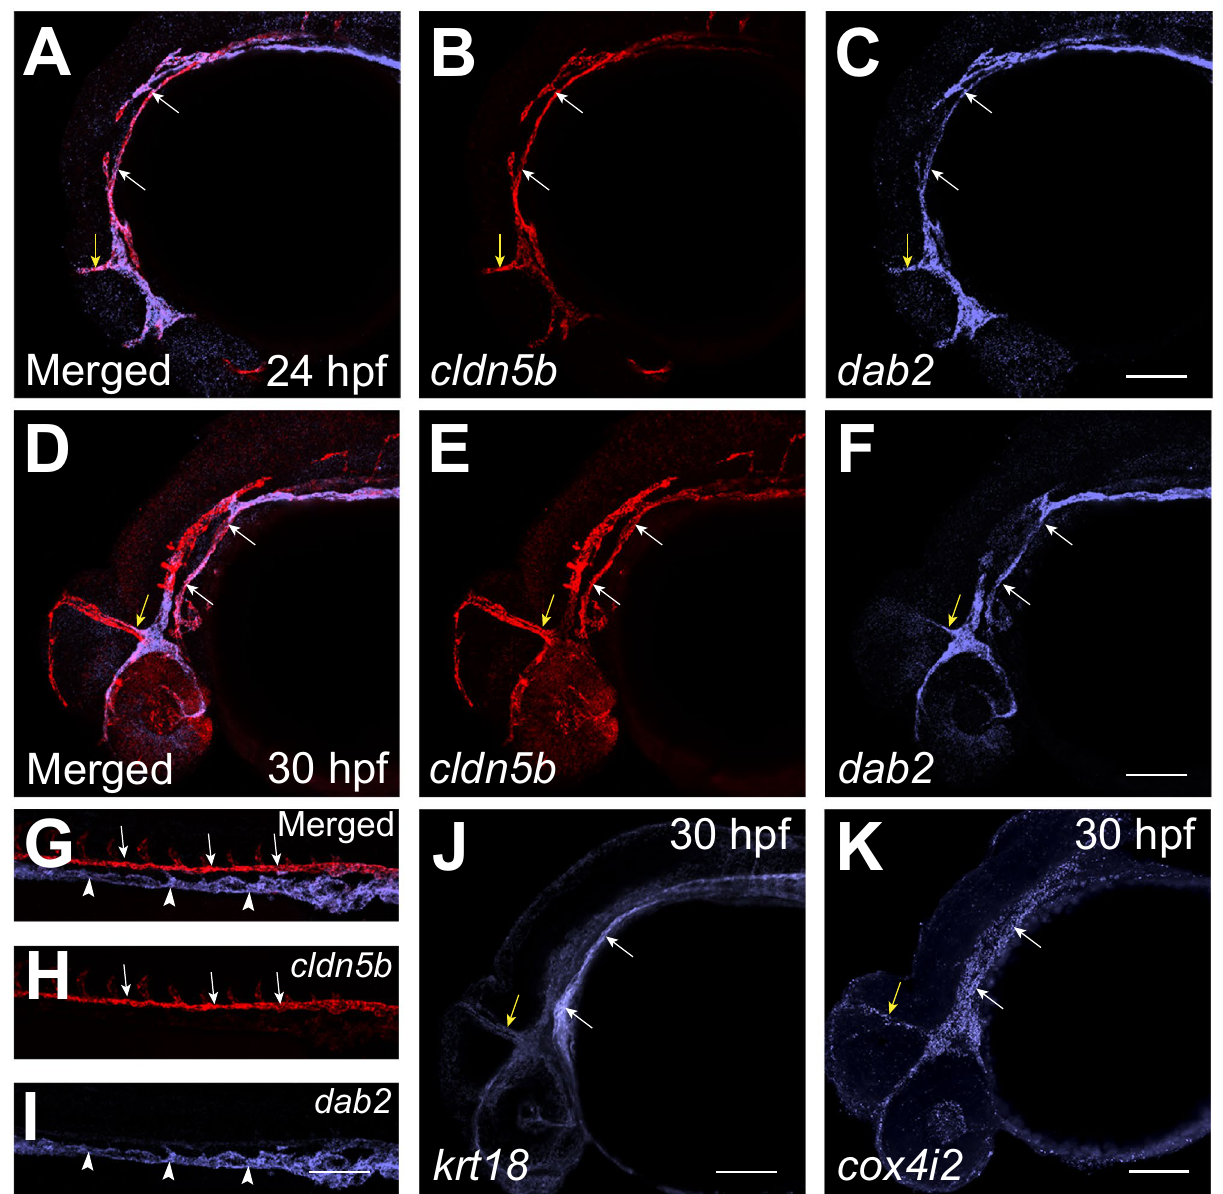
Figure 6. Vascular endothelial (VE)-other cluster #6 corresponds to cells in cranial vasculature. ( A – F ) Two color fluorescent ISH analysis for the expression of cldn5b and dab2 at the 24 hpf and 30 hpf stages. Note that cldn5b and dab2 are co-expressed in the PHBC (white arrows) and MCeV (yellow arrows) at the 24 hpf and 30 hpf stages. ( G – I ) Two color fluorescent ISH analysis for the expression of arterial cldn5b and venous dab2 in the trunk region of 24 hpf embryos. Note that cldn5b and dab2 have distinct non-overlapping expression in the DA (arrows) and PCV (arrowheads) respectively. ( J , K ) Fluorescent ISH analysis for the expression of krt18 and cox4i2 in the head region of 30 hpf embryos. Both markers are expressed in the PHBC (white arrows) and MCeV (yellow arrows). PHBC primordial hindbrain channels, MCeV mid cerebral vein, DA dorsal aorta, PCV posterior cardinal vein. Scale bars: 100